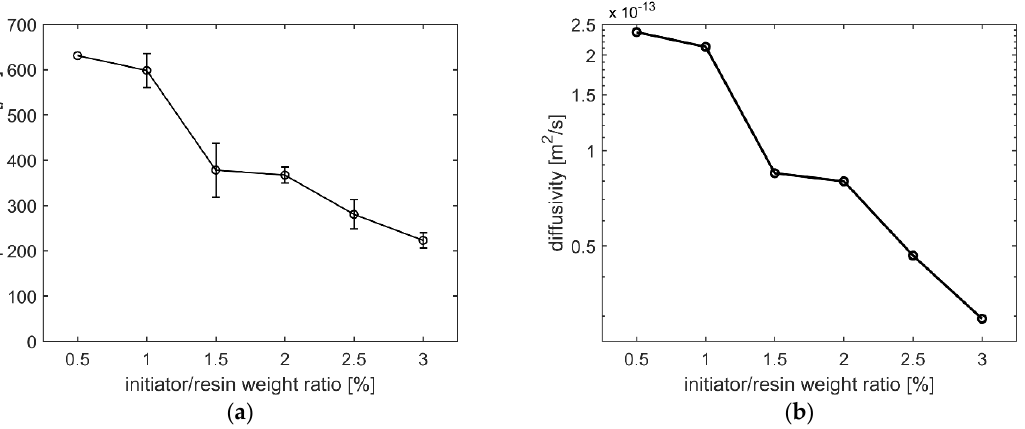
Figure 5. ( a ) Interphase thickness vs. MEKP/UPR weight ratio. Markers represent mean values and error bars represent ± one standard deviation (no error bar at 0.5%, since only 2 specimens were tested at that ratio). ( b ) Diffusivity vs. initiator/resin weight ratio calculated based on Equation (1) using the gelation times in Figure 3b and interphase thicknesses in Figure 5a.